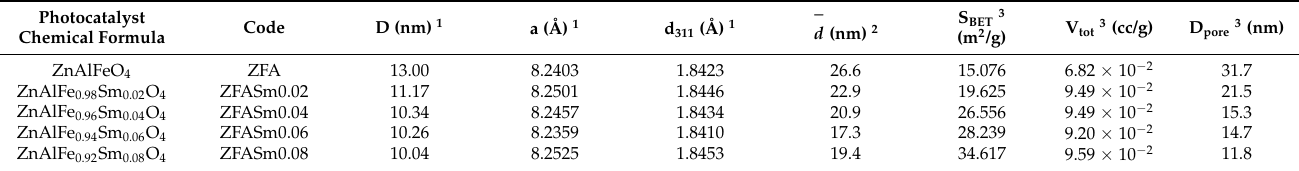
Table 1. Calculated data for ZnAlFe 1 − x Sm x O 4 (x = 0, 0.02, 0.04, 0.06, 0.08) photocatalysts.